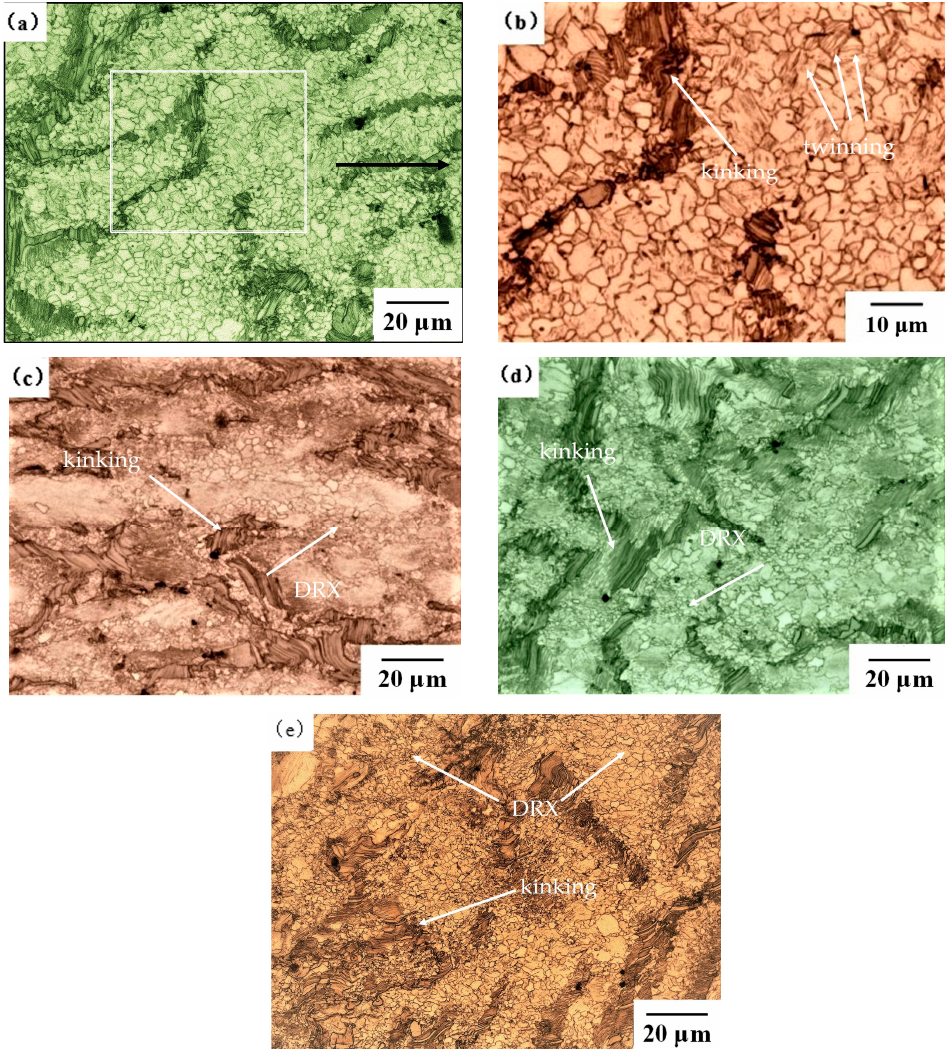
Figure 4. OM images of the DRX and kinking inside the deformed alloys at 400 °C and several strain rates: ( a , b )1 s − 1 ; ( c ) 0.1 s − 1 ; ( d ) 0.01 s − 1 ; and ( e ) 0.001 s − 1 .